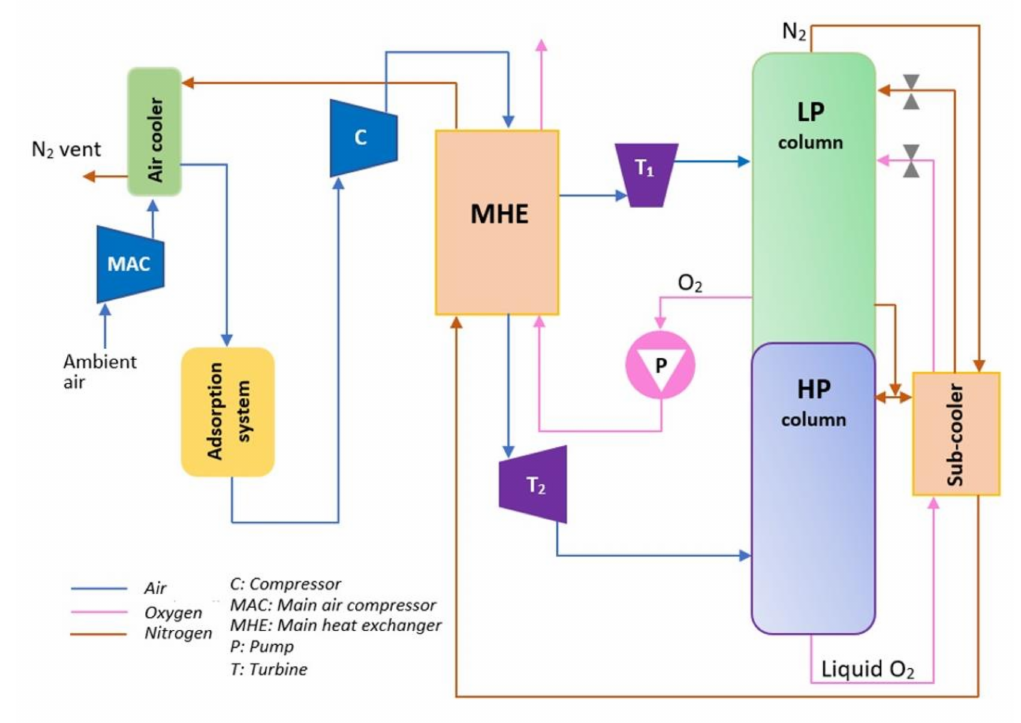
Figure 2. Schematic of a cryogenic air separation